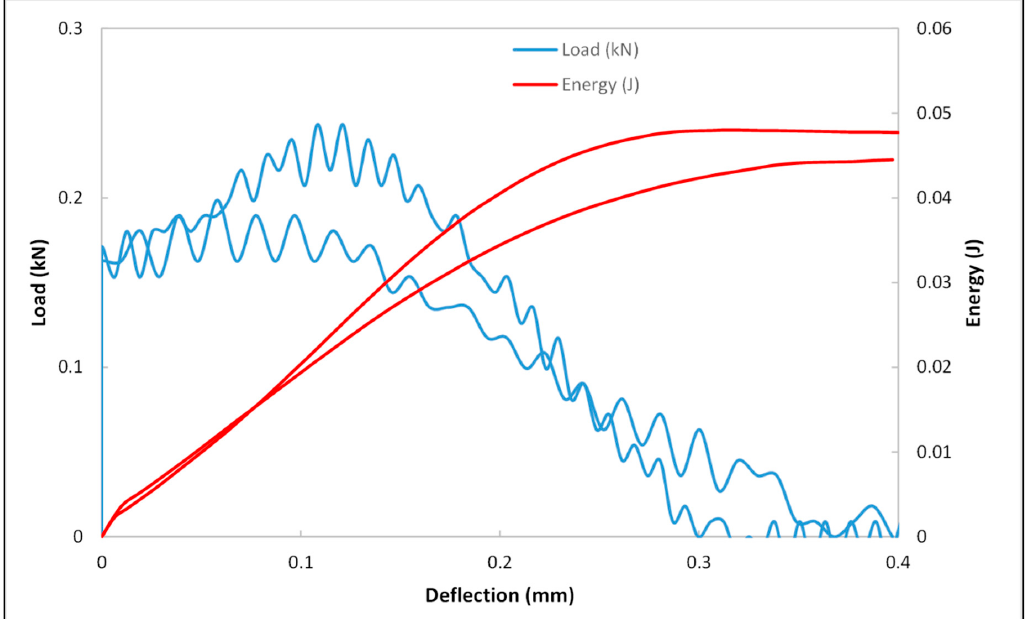
Figure 8. Load and deflection plot of dry cement mortar samples.